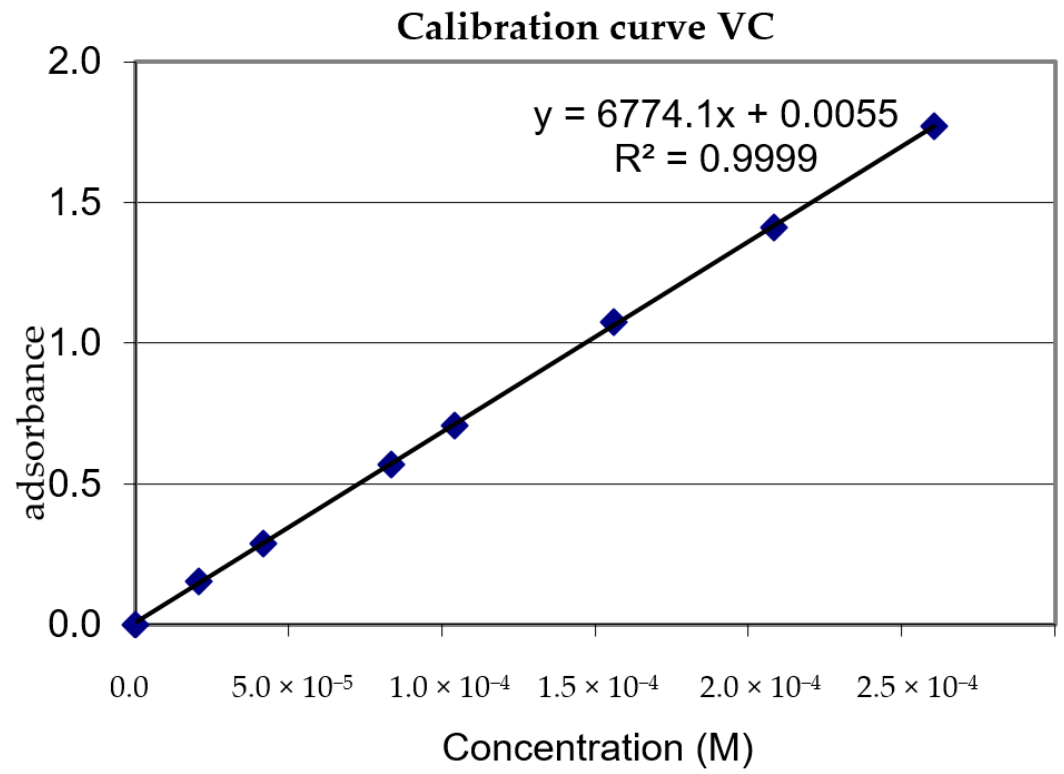
Figure 18. Calibration curve of VC at 272 nm, absorbance versus concentration.